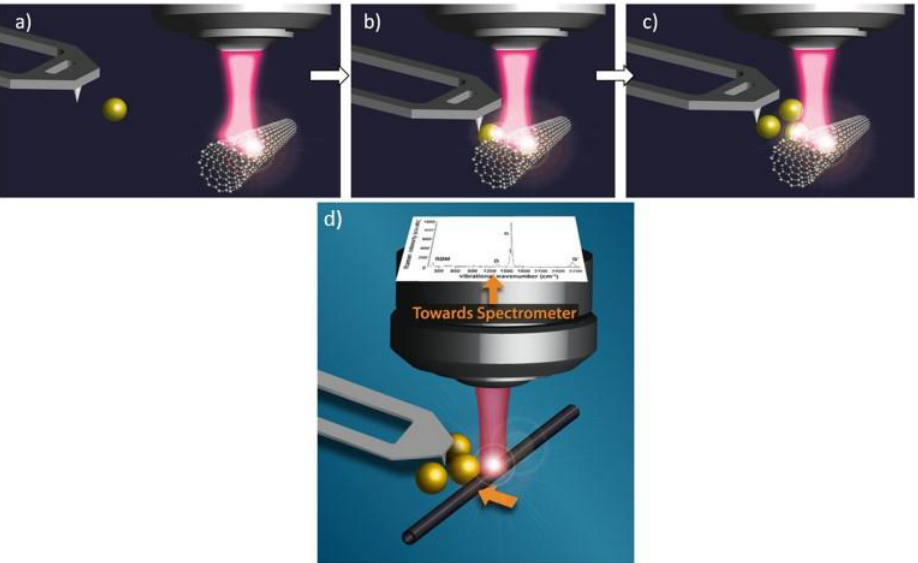
Figure 2. Scheme of our experiments of Raman-AFM Manipulation combining. ( a ) Manipulation of the first individual Au Np, coming from the reservoir; ( b ) Approach of the SWCNT by the Au Np pushed by the AFM tip; ( c ) Designing of the nanostructure (plasmonic molecule) with three plasmonic atoms and ( d ) Monitoring by Raman spectroscopy at several wavelengths of excitation. Materials 2019 , 12 FOR PEER REVIEW